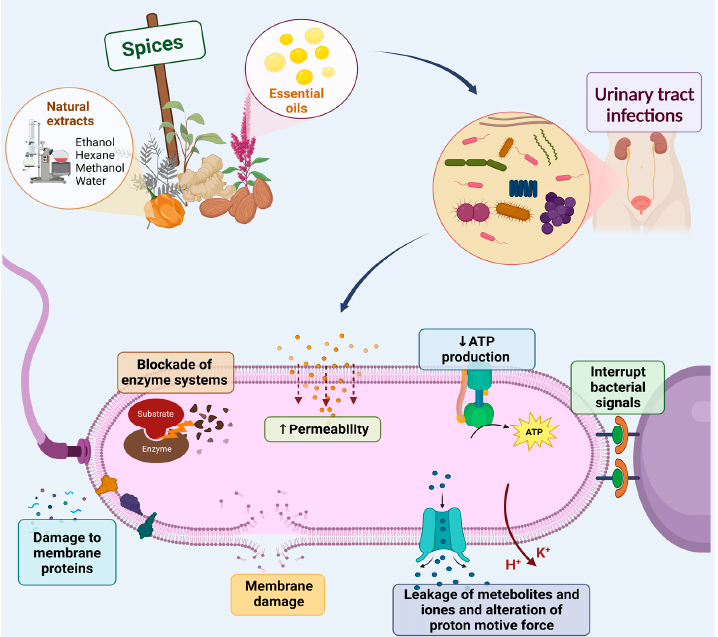
Figure 1. Antibacterial effects of essential oils (EOs). EOs kill bacteria by directly damaging cell membrane lipids and proteins, blocking enzyme systems, altering pH gradient and proton-motive force electrical potential, increasing permeability, disrupting bacterial signaling, and decreasing the adenosine triphosphate (ATP). H + : hydrogen; K + : potassium. Created with Biorender.com.